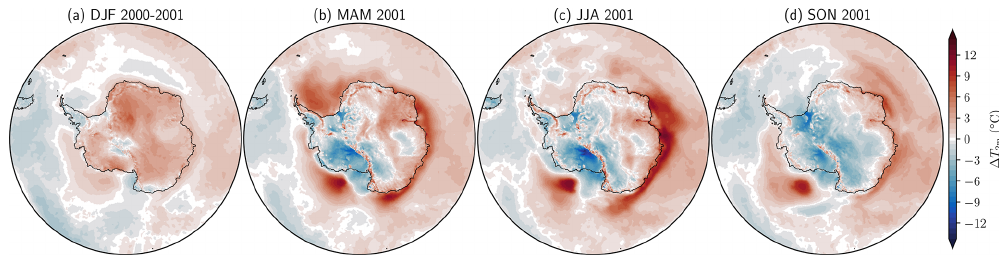
Figure 11. (PARASO–ERA5) differences in seasonally averaged 2m air temperature for the second simulated year.